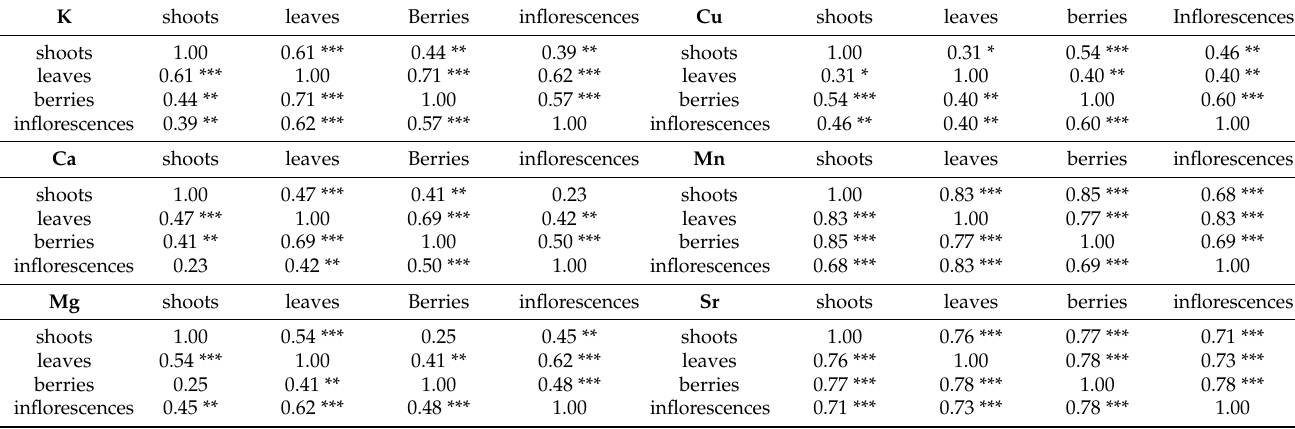
Table 2. Correlation coefficients for mineral contents between different plant parts of elderberry interspecific